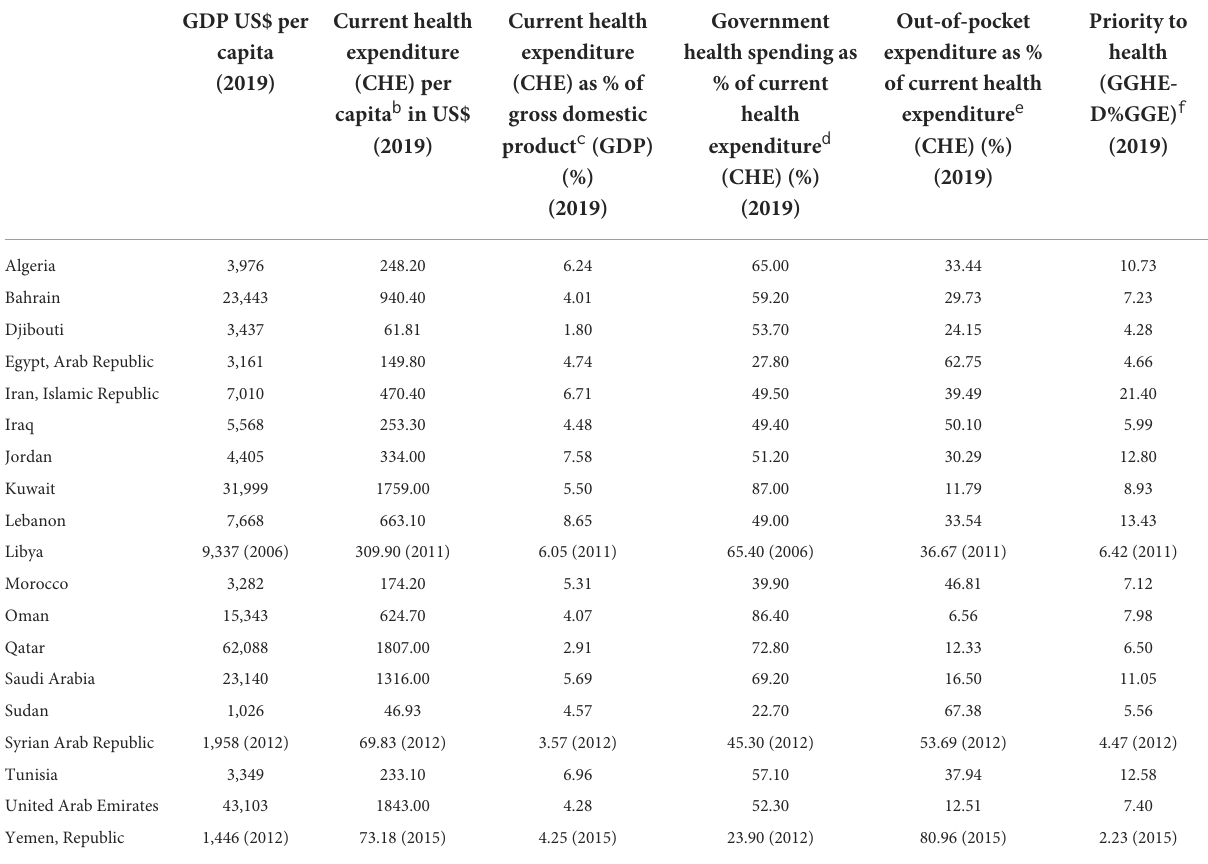
TABLE 2 Key health expenditure statistics for some countries in the Middle East and North Africa region a